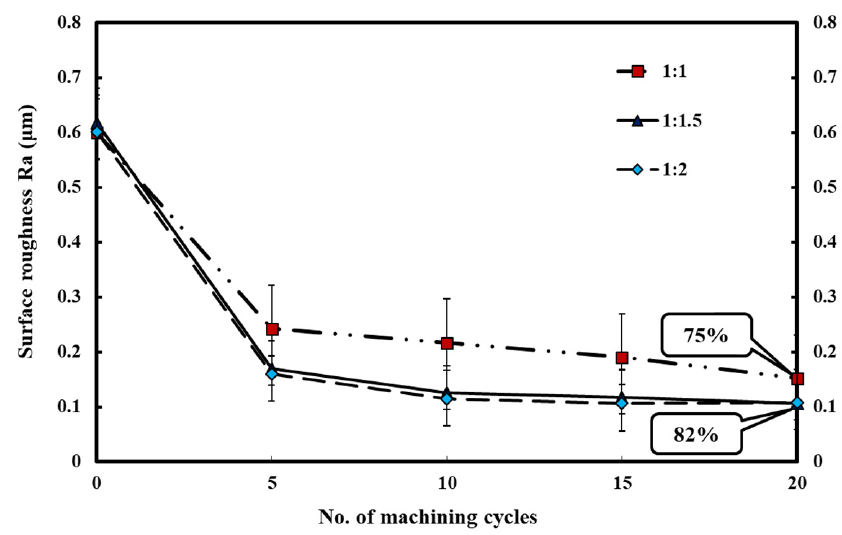
Figure 11. Effects of concentration ratios of silicone gel and abrasive on surface roughness.